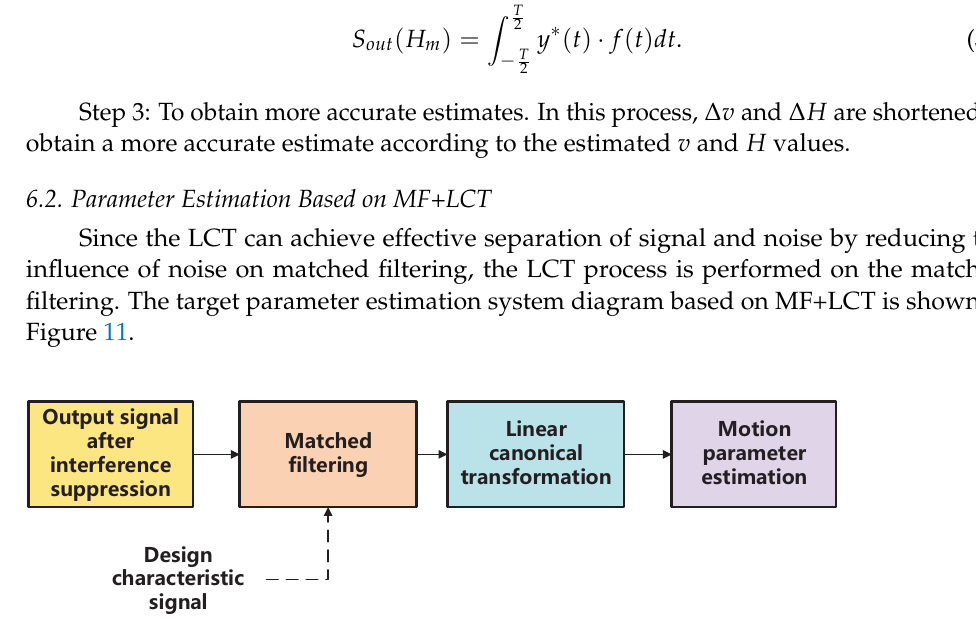
Figure 11. Target parameter estimation system diagram based on